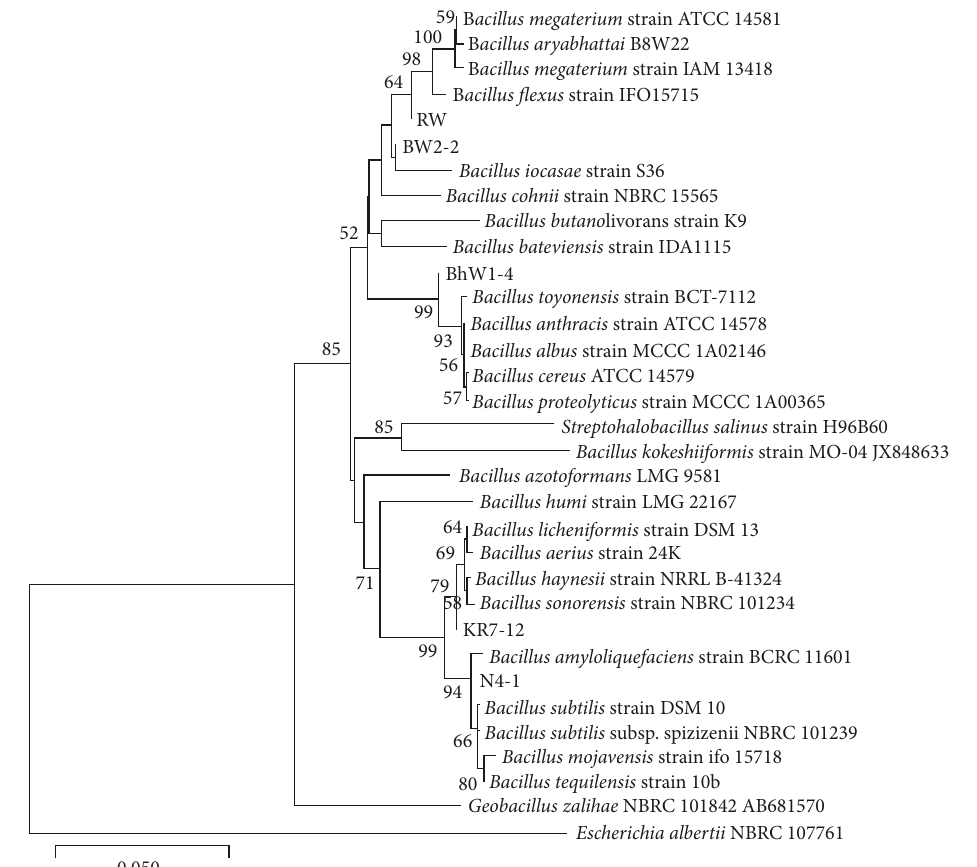
Figure 6: Neighbor-joining tree based on 16S rRNA gene sequences, showing the position of isolates RW, BW2-2, Bhw1-4, KR7-12, and N4- 1, and their closely related reference strains inclusive of other Bacillus species. Bootstrap values (expressed as percentages of 1000 rep- lications) above 50% are shown. Bar 0.01 substitutions per nucleotide position. Escherichia albertii NBRC 107761 is used as an